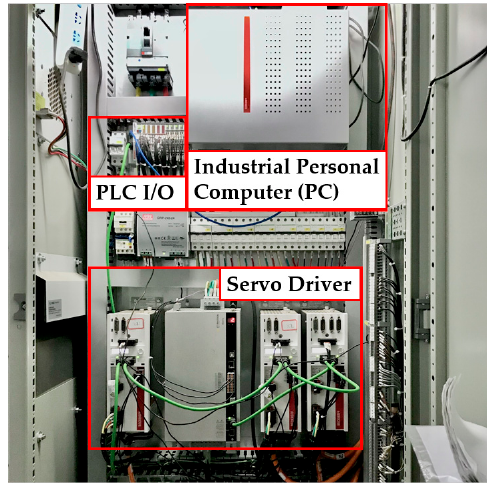
Figure 9. The hardware of the compensation system.